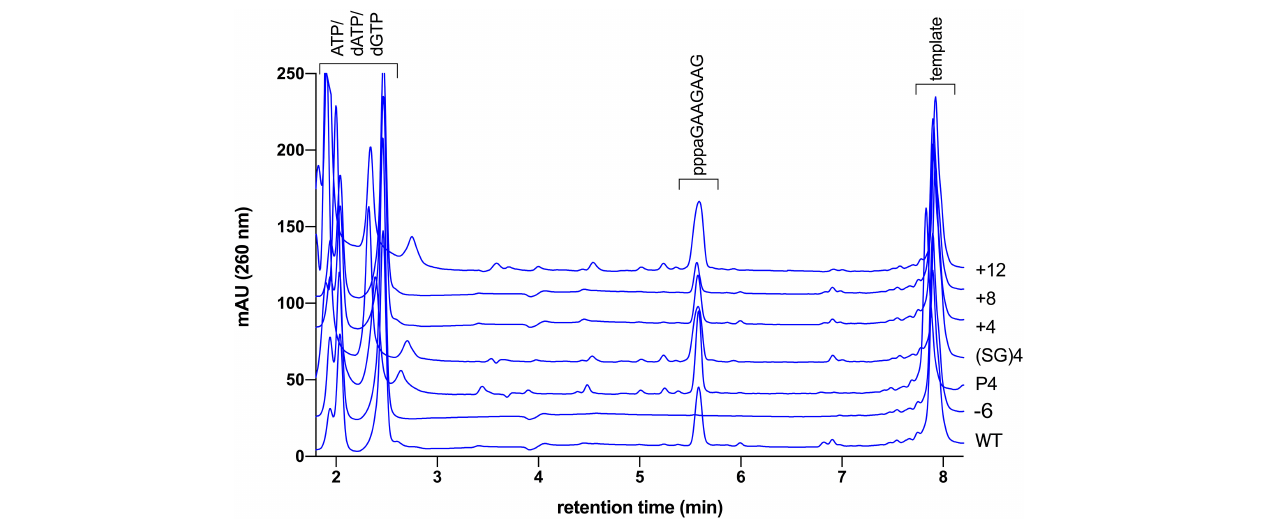
FIGURE 4 | HPLC based primer length determination of linker length mutants. Primase assay of wild type primase incubated with template “mixed” produces a unit length primer of 8 nt (ppppaGAAGAAG). The same main product is observed in varying amount with the linker mutants (cid:49) 6, P4, (SG) 4 , +4, +8, and +12. The identity of the product was confirmed to be the ppppaGAAGAAG with MALDI-TOF mass spectrometry (calculated exact mass 2,746.38 gmol − 1 , found: 2,746.04).